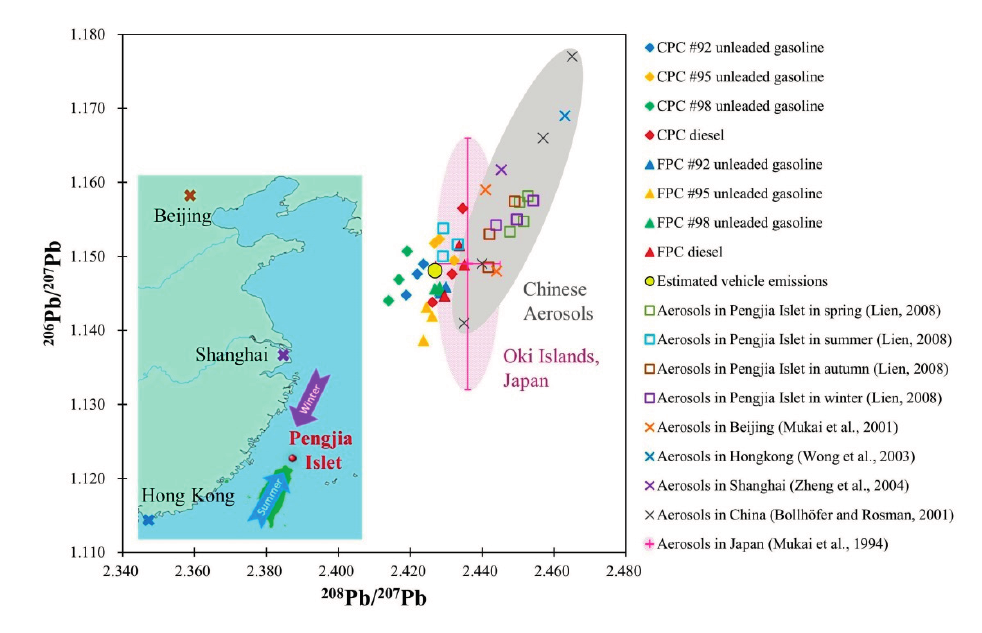
Figure 4. Scatter plot of 208 Pb/ 207 Pb versus 206 Pb/ 207 Pb for fuel products, estimated Taiwanese vehicle emissions (the yellow circle), together with the seasonal aerosols collected in Pengjia Islet by Lien [20], drawn as blank squares. The gray ellipse area represents Chinese aerosols [10,38,44,45]. In addition, aerosol records in Oki Islands, Japan [8] recalculated and summarized are also shown as a pink